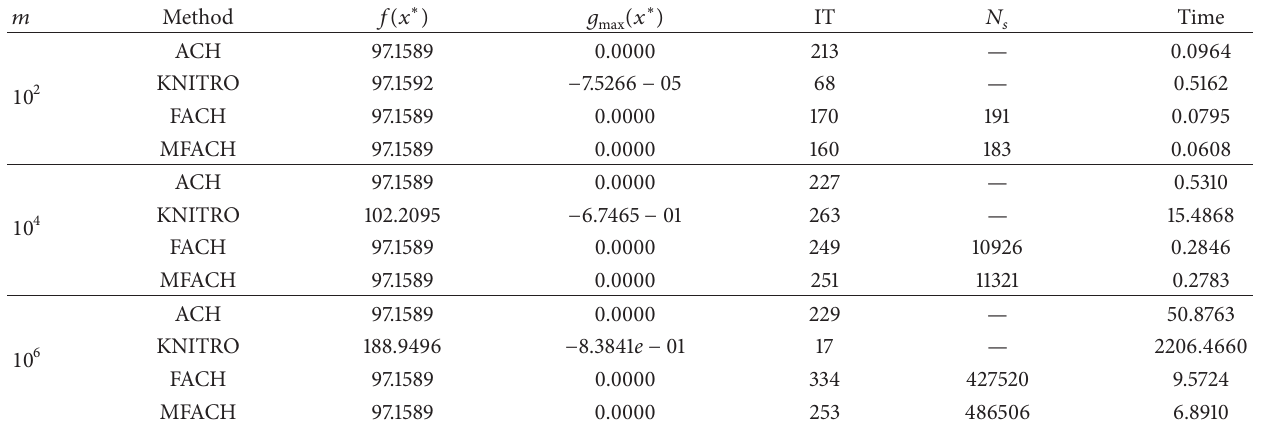
Table 5: Test results for Example 19.